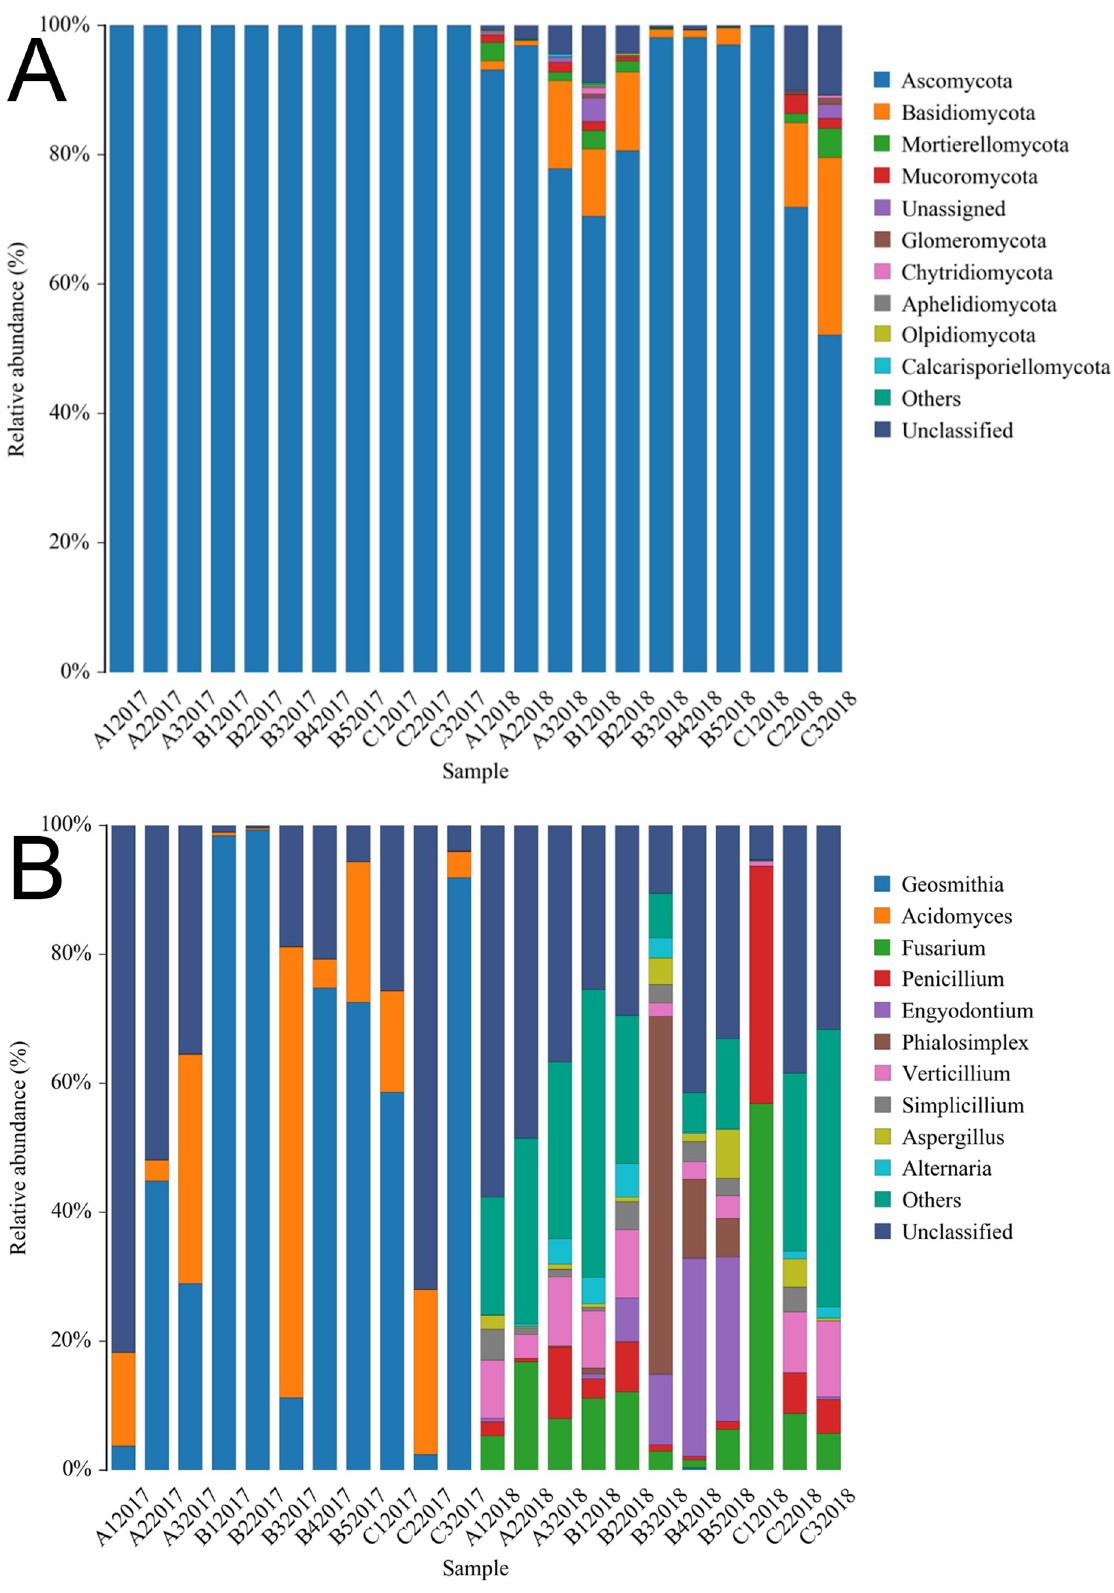
Fig 3. Distribution patterns of fungi in 2017 and 2018 at the phylum (A) and genus (B) level in all 22 samples. https://doi.org/10.1371/journal.pone.0236165.g003 PLOS ONE | https://doi.org/10.1371/journal.pone.0236165 July 22,